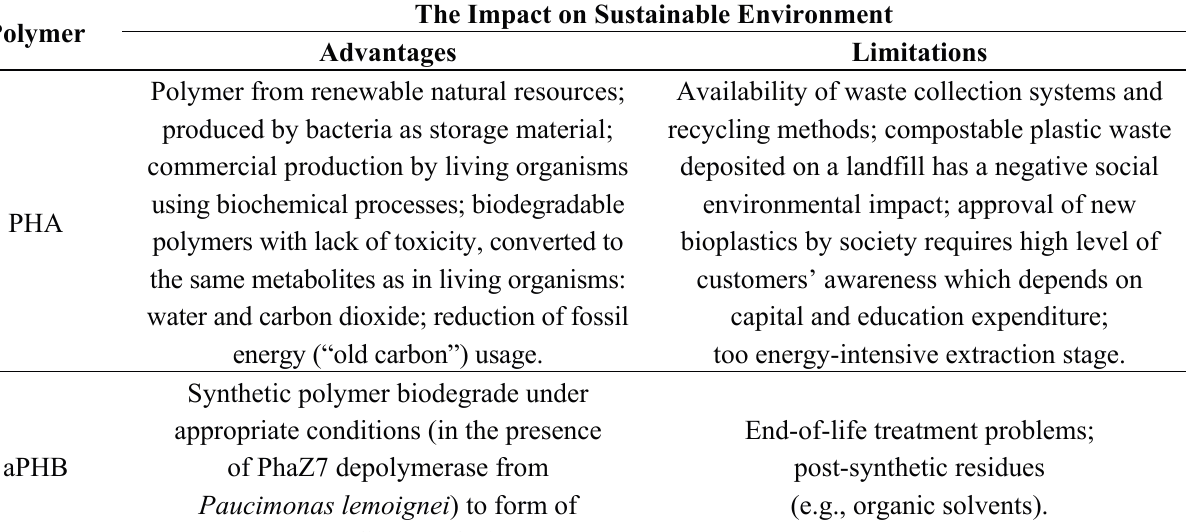
Table 3. The environmental impact of polyester-based (bio)degradable polymers.